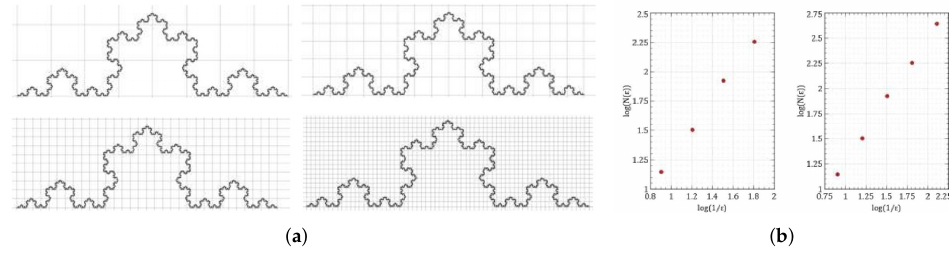
Figure 6. Approximating box-counting dimension of the Koch curve. ( a ) Grids of different sizes on the Koch curve, ( b ) double logarithmic